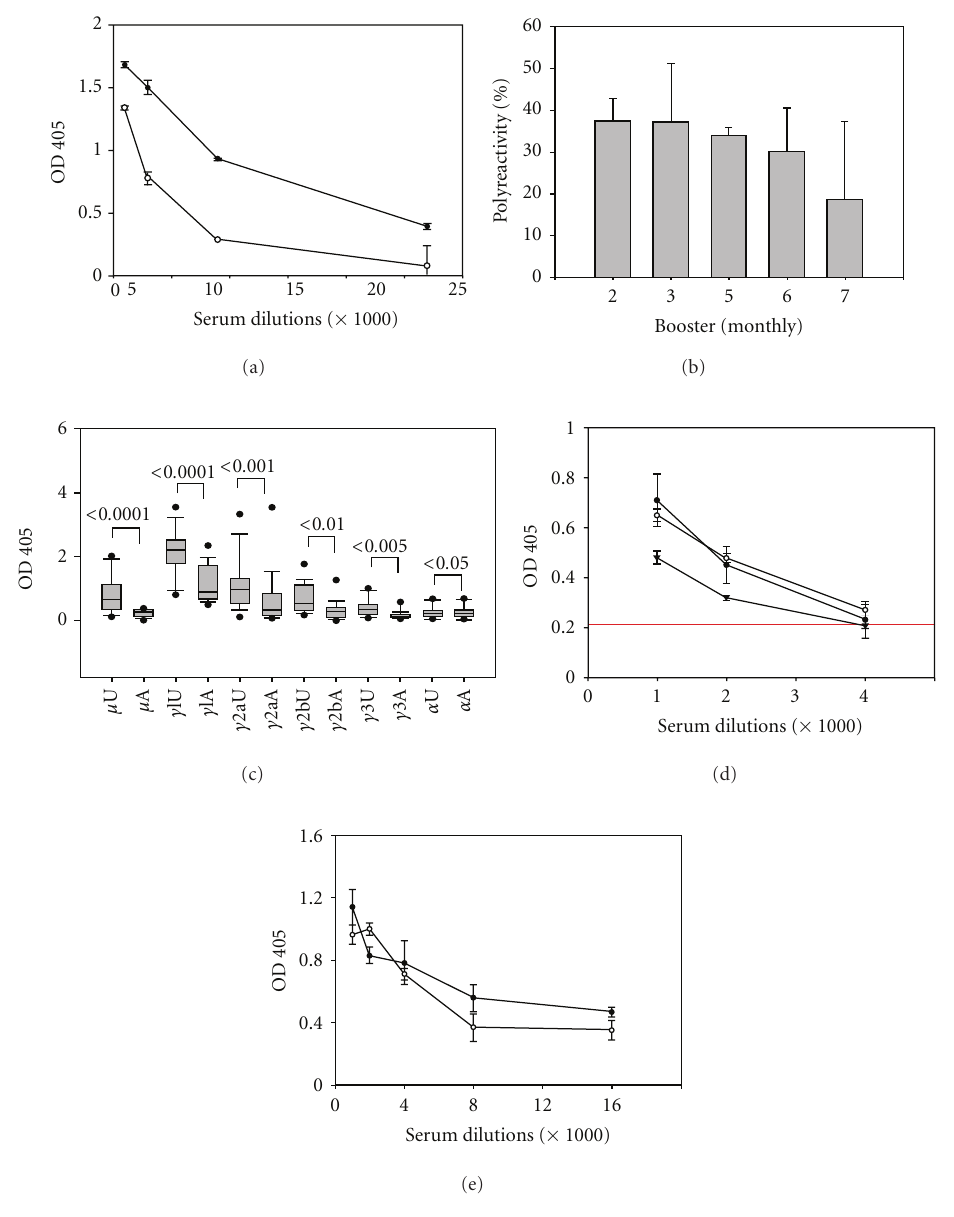
Figure 4: Polyreactive serum anti-PfP0C0 response induced following repeated immunizations with rPfP0 but not BSA-PfP0C0. (a) Sera of mice administered recombinant PfP0 were treated or not with DNP-sepharose beads. Anti-PfP0C0 titre before and after treatment was determined in an ELISA. A representative example of anti-PfP0C0 response of DNP adsorbed (empty circles) and unadsorbed (filled circles) sera. Error bars represent the SEM of three readings. (b) Mice were immunized by four weekly and up to seven monthly injections of rPfP0. Aliquots of the sera were treated with DNP-sepharose beads to adsorb out polyreactive antibodies. The bar graphs depict the percent polyreactivity in sera of mice after multiple immunizations as indicated. Error bars represent the SEM of 3 sera. (c) Box plots showing the 25th and 75th percentiles, together with the median, with whiskers showing the minimum and maximum di ff erence and filled circles representing the outliers, in the ELISA OD responses of DNP unadsorbed (U) and adsorbed (A) sera of all 21 mice immunized with recombinant PfP0; μ (IgM), γ 1 (IgG1) γ 2a (IgG2a), γ 2b (IgG2b), γ 3 (IgG3), and α (IgA). Statistically significant values obtained by Paired Wilcoxan signed-rank test are indicated. (d) Autoreactivity of a representative serum sample against bovine insulin (closed circle), dsDNA (open circle), and ssDNA (closed triangle) of mice immunized with rPfP0. Red line represents the response of control unimmunized sera at the lowest dilution (1:1000). Error bars represent the SEM of three readings. Similar results were obtained with other sera. (e) Mice were administered BSA-PfP0C0, and the sera were treated or not with DNP-sepharose beads. Anti-PfP0C0 titre before and after treatment was determined in ELISA. A representative example of anti-PfP0C0 response of DNP adsorbed (empty circles) and unadsorbed (filled circles) sera. Error bars represent the SEM of three